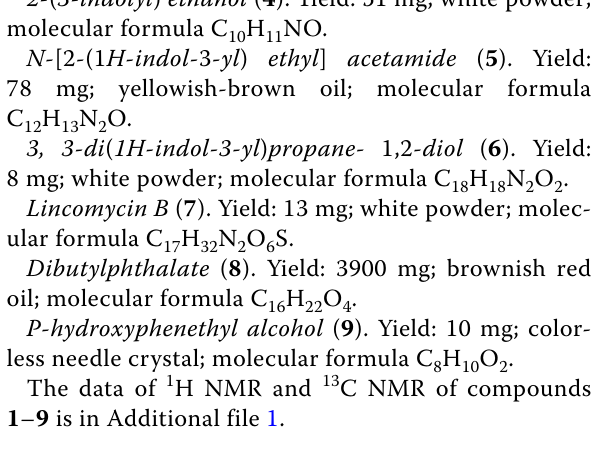
Table 2 The antiviral activity of compounds isolated from strain E303035 against PVY